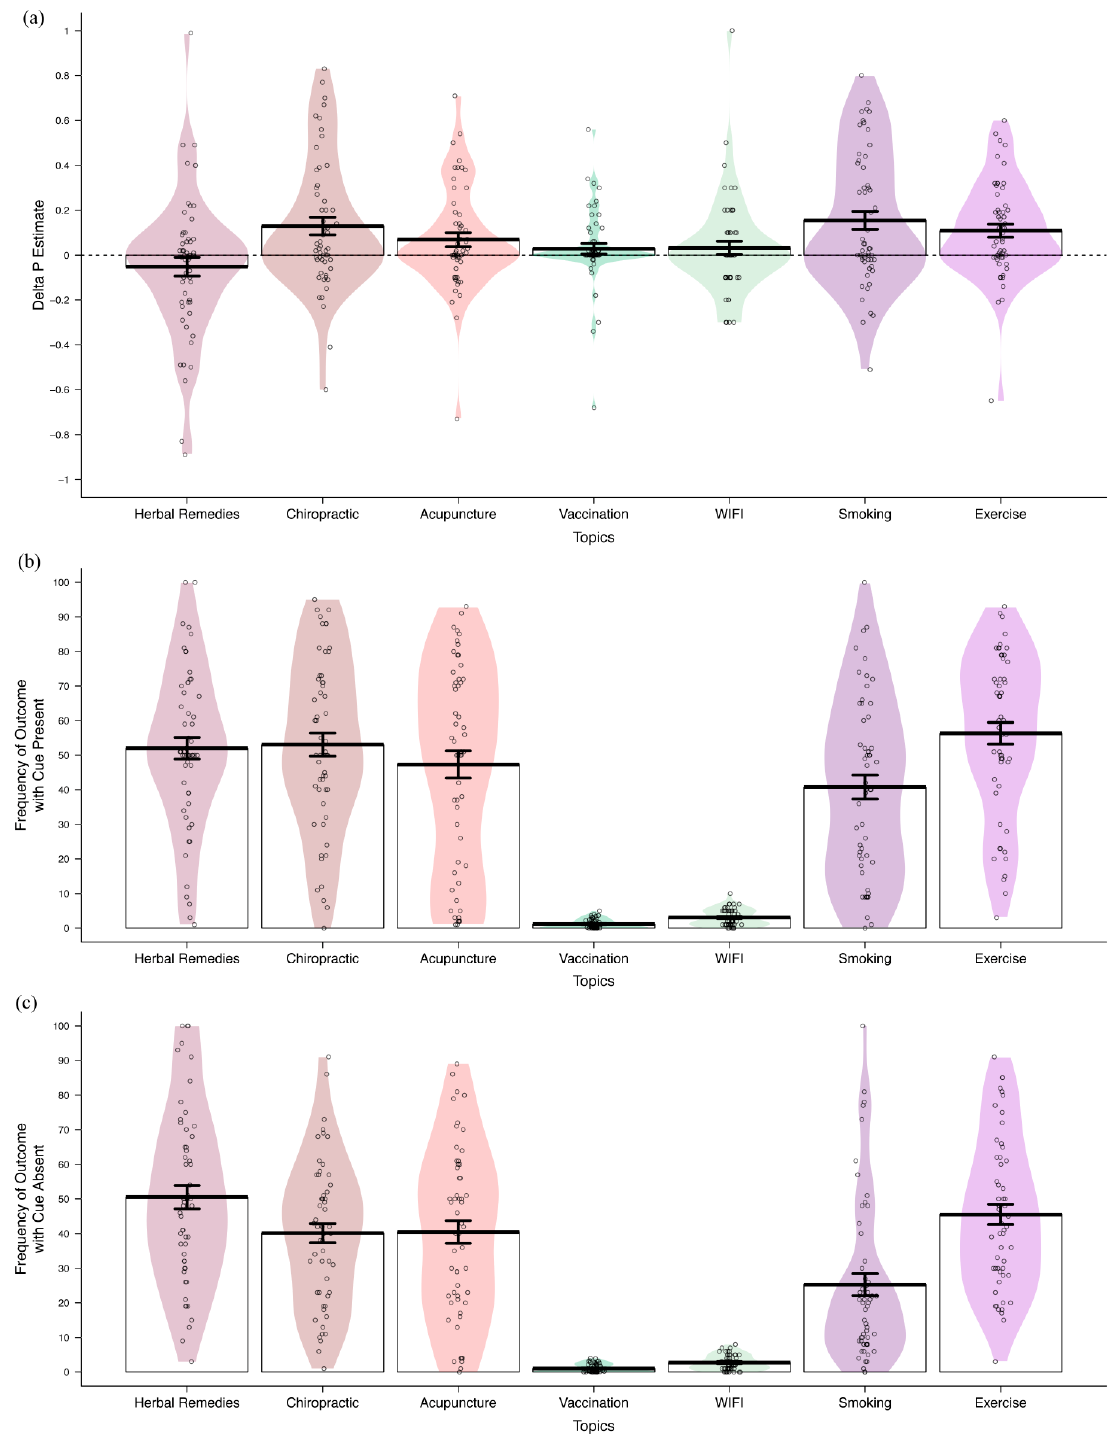
Figure 2. ( a ) Delta p estimates for each target topic, measured as a difference in the probability of the outcome occurring in the presence and absence of the target health behaviour. ( b ) Reported frequency (from 0–100%) of the target outcome occurring in the presence of the cause, and ( c ) in the absence of the cause. Frequency estimates for autism were made from a scale of 0–5%, and cancer estimates were made from a scale of 0–10%. Coloured region denotes the density of the estimates along the Y -axis. Labels on the X -axis denotes the topic area by cue name. Delta p estimates were only calculated for participants who provided both outcome frequency estimates (with and without the cause